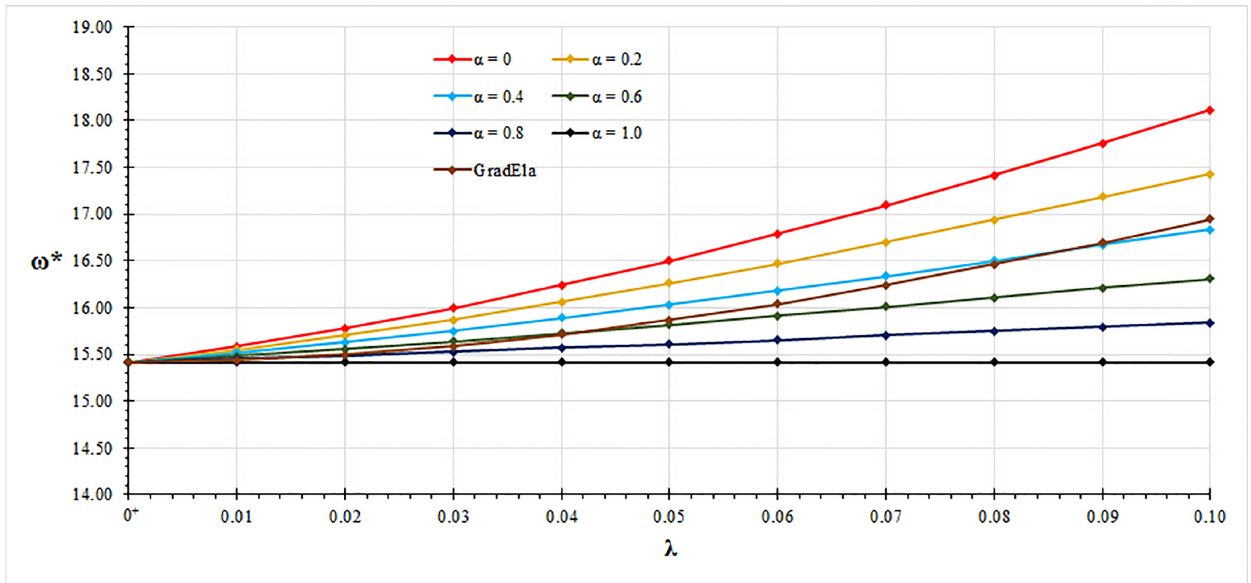
Figure 4. Clamped-pinned beam: non-dimensional fundamental natural frequency ω ∗ vs. nonlocal parameter λ for α ∈ { 0, 0.2, 0.4, 0.6, 0.8, 1.0 }